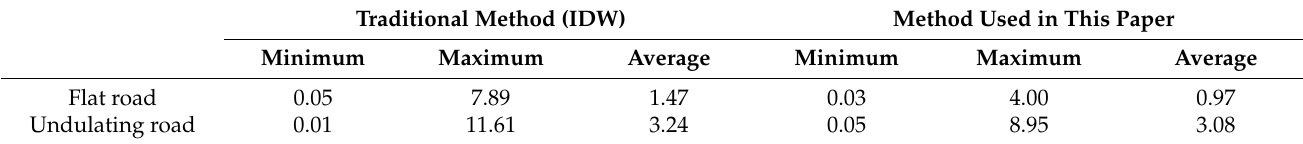
Table 2. Statistics of road gradient index ( ◦ ).